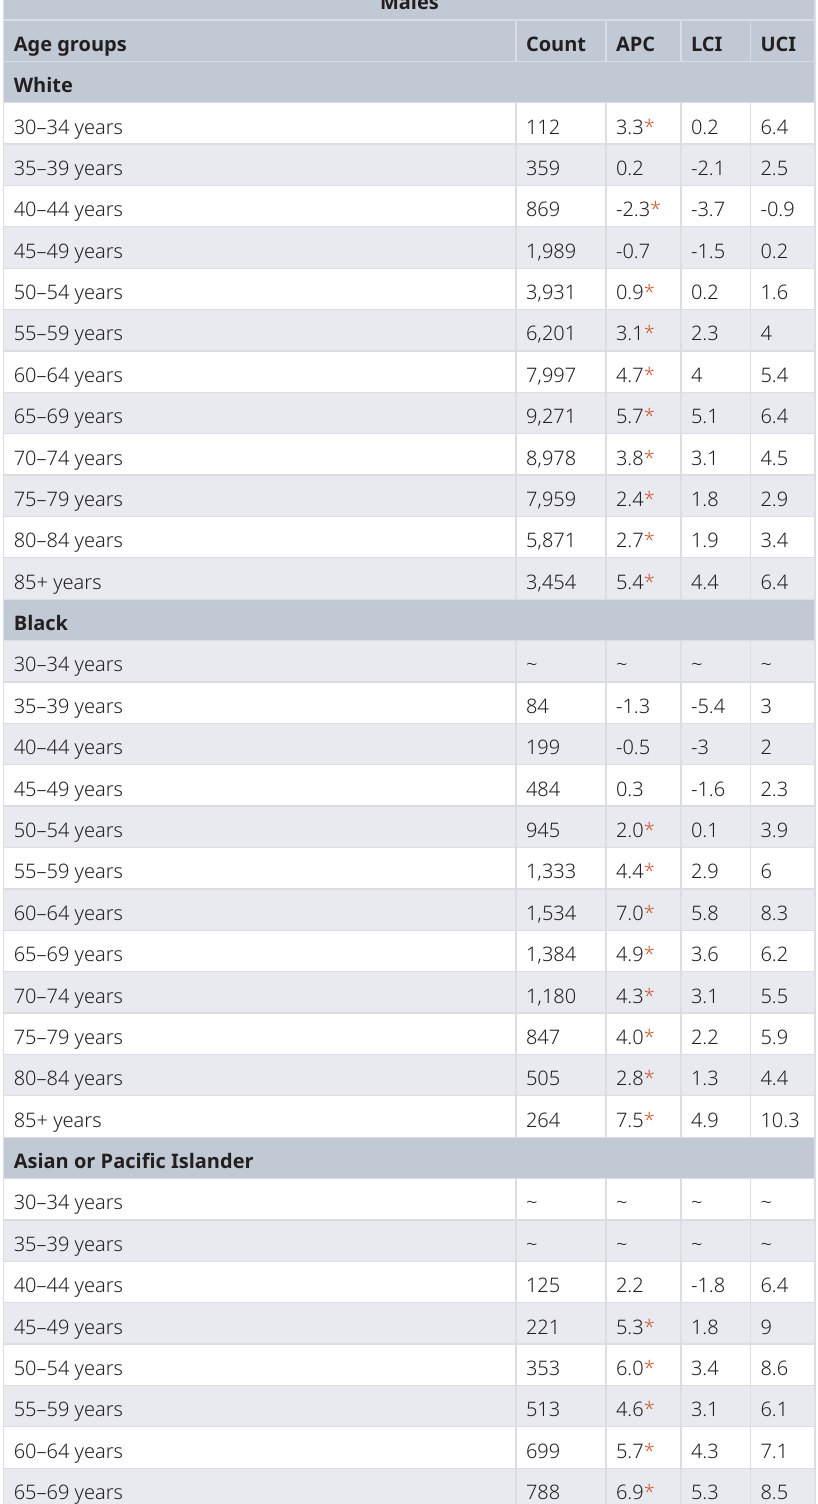
Table 2. Total cases and Annual Percentage Changes (APCs) of pancreatic cancer by race, gender, and age group (2000–2017). Males Age groups Count APC LCI UCI White 30–34